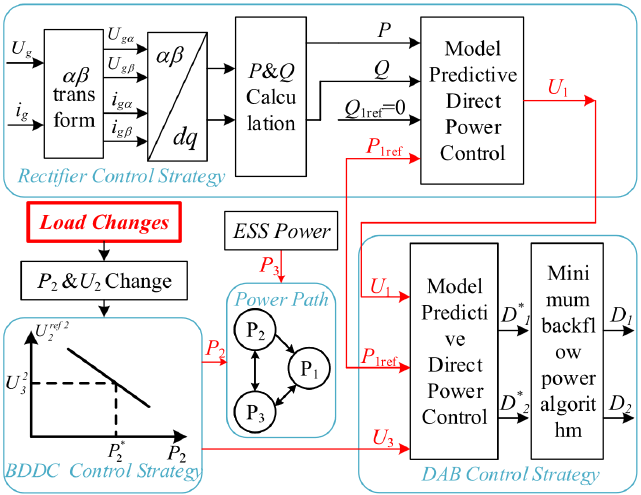
Figure 5. Overall MPC-based control scheme proposed in [31].